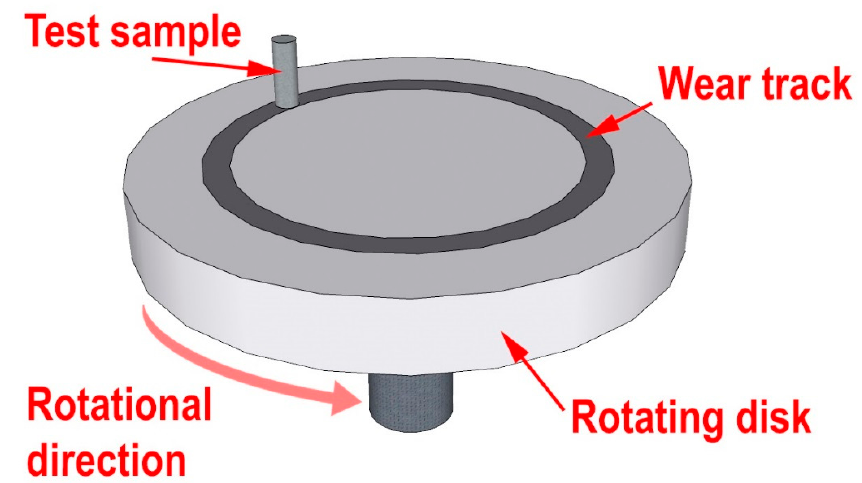
Figure 1. Schematic configuration of the tribology machine employed for the wear test. The hardness (H) of the samples was measured by pressing the ball ISO 2039/1-87 on the UMT-3 universal testing tribometer. The diameter of the steel ball indenter was 5.0 ± 0.05 mm, accuracy of indentation depth measurement was ±0.005 mm, the indentation time ±0.1 s, and the load was 132 N. The sample was 30 × 30 mm in size and 4.0 ± 0.1 mm thick.